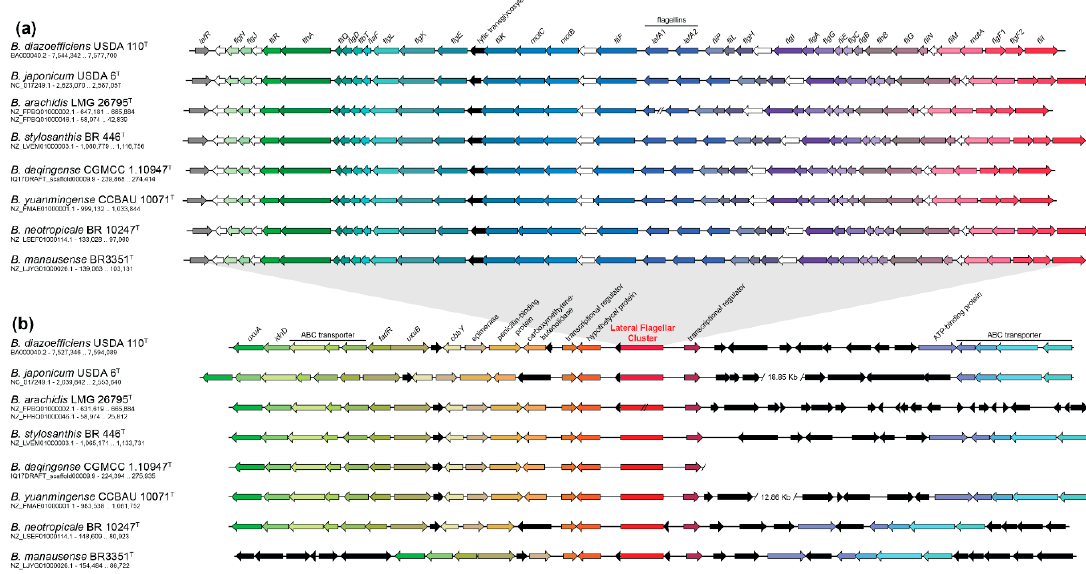
Figure 2. Synteny of the lateral flagellar system and genetic context among type strains of the B. japonicum PG. (a) Synteny of the lateral flagellar system showing high conservation and flagellins duplication events. White arrows indicate hypothetical proteins. (b) Synteny of the genetic context surrounding the lateral flagellar system (red square, not to scale). The upstream region synteny of the lateral flagellum is maintained across type strains while downstream region has suffered extensive genomic reorganizations. Black arrows represent hypothetical proteins and/or coding sequences with no homologous sequences in the genetic context among the genomes represented. NCBI accs. no. and coordinates of the regions shown are specified under the species name.